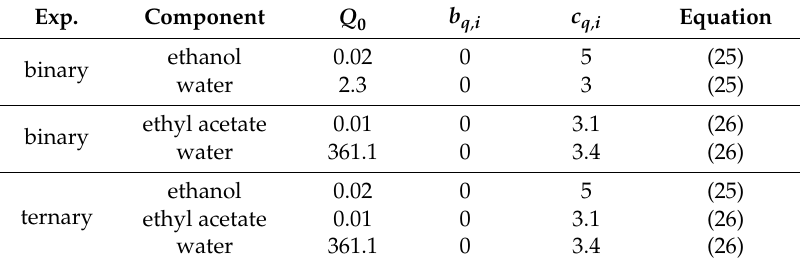
Table 6. Determined permeance data for the two binary systems by a nonlinear least squares regression, minimizing the weighted square error between experiments and simulation. For the simulation of the ternary system, the organic solvent permeance data was adopted from the binary data. The water permeance data for the ternary simulation was adopted from the ethyl acetate/water data. Exp.